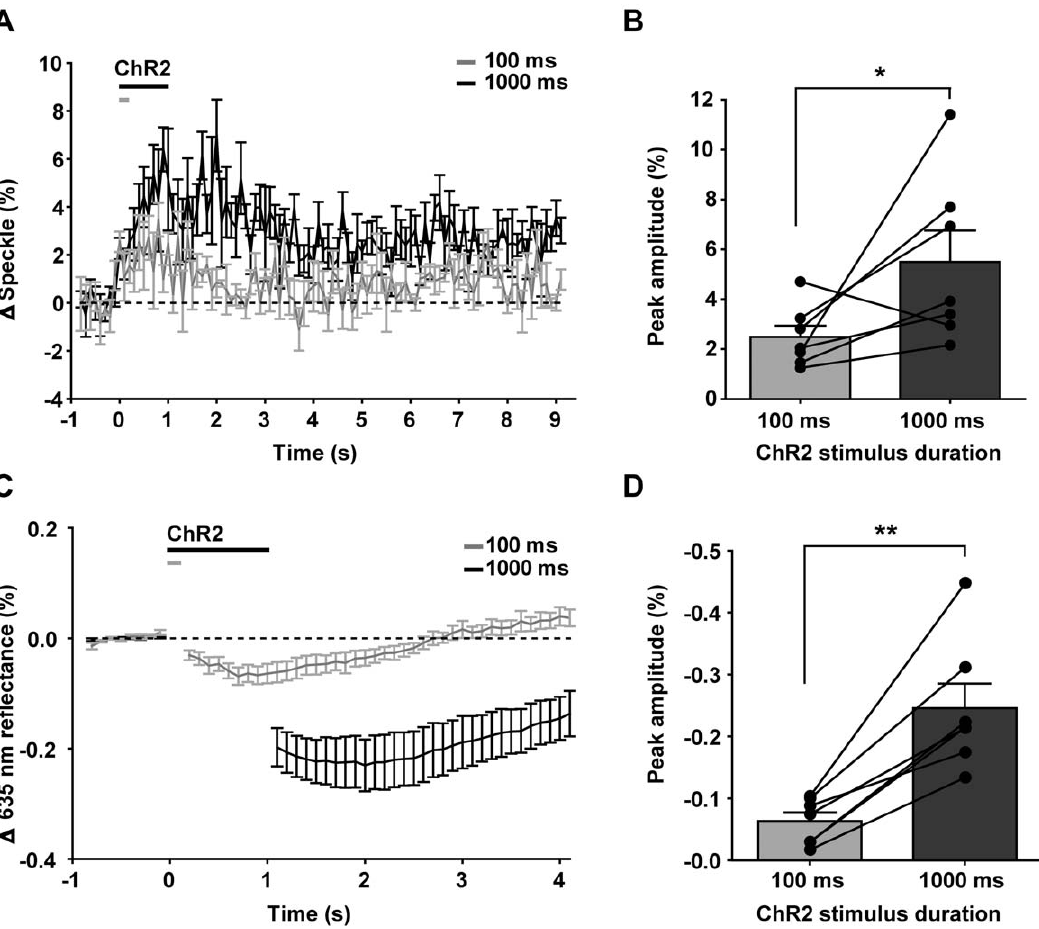
Figure 2. Effect of varying ChR2 stimulus train duration on evoked hemodynamic responses. A, Temporal profiles of laser speckle responses evoked by 100 ms (grey, n=7) and 1000 ms of ChR2 stimulation (black, n=7). B, Peak amplitudes of temporal profiles in (A), compared within the same animals (p=0.0294, n=7). C, Temporal profiles of IOS responses evoked by 100 ms (grey, n=7) and 1000 ms of ChR2 stimulation (black, n=7). D, Peak amplitudes of temporal profiles in (C), compared within the same animals (p=0.0012, n=7).